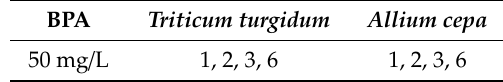
Table 1. Exposure of seedlings to bisphenol A (BPA) in hours.